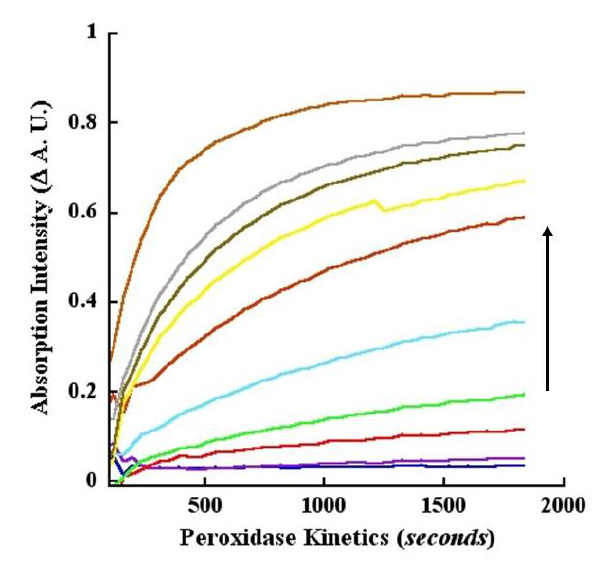
Figure 10B. Kinetics of CA oxidation by peroxidase monitored at 295 nm. All reaction conditions were the same as described for Figure 10A, except that the data was obtained at 295 nm absorption, and transformed as B − S Δ A.U. values. Consequently, the tracings showed a progressively increasing and positive character in contrast to the declining intensities of Figure 10A. The concentrations of peroxidase represented by the various color tracings and indicated by the upward pointing arrow are the same as those shown in Figure